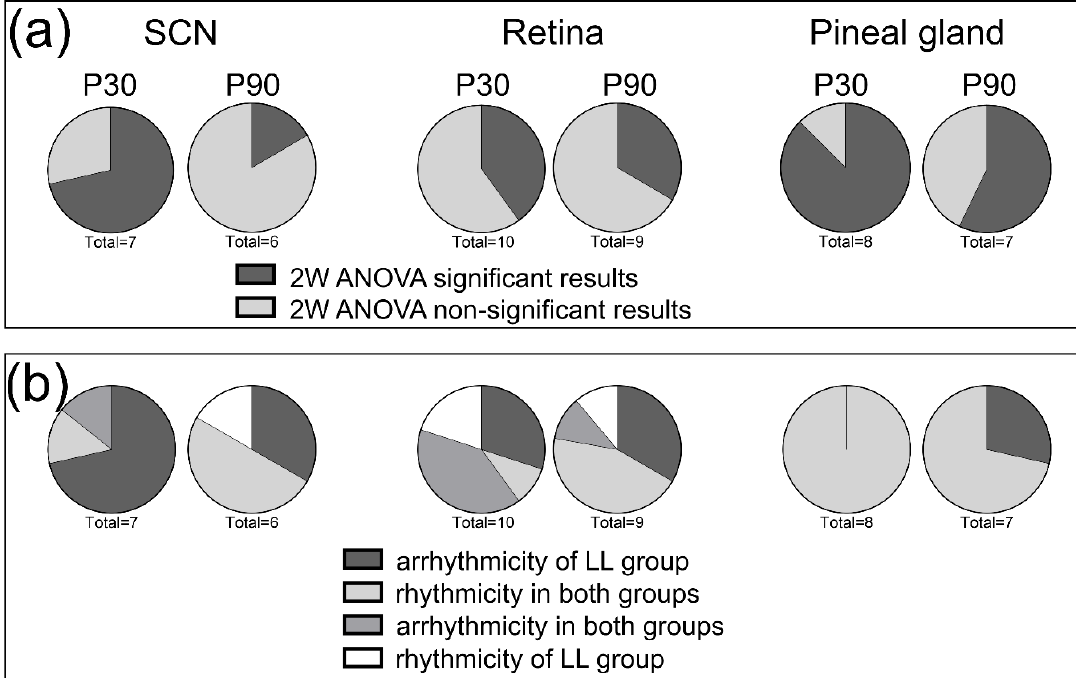
Figure 8. Pie charts showing ( a ) the relative distribution of statistically significant differences between LD and LL profiles of all gene expressions in brain structures obtained by two-way ANOVA; and ( b ) relative ratio of rhythmic and non-rhythmic expression profiles in both groups and all brain structures.